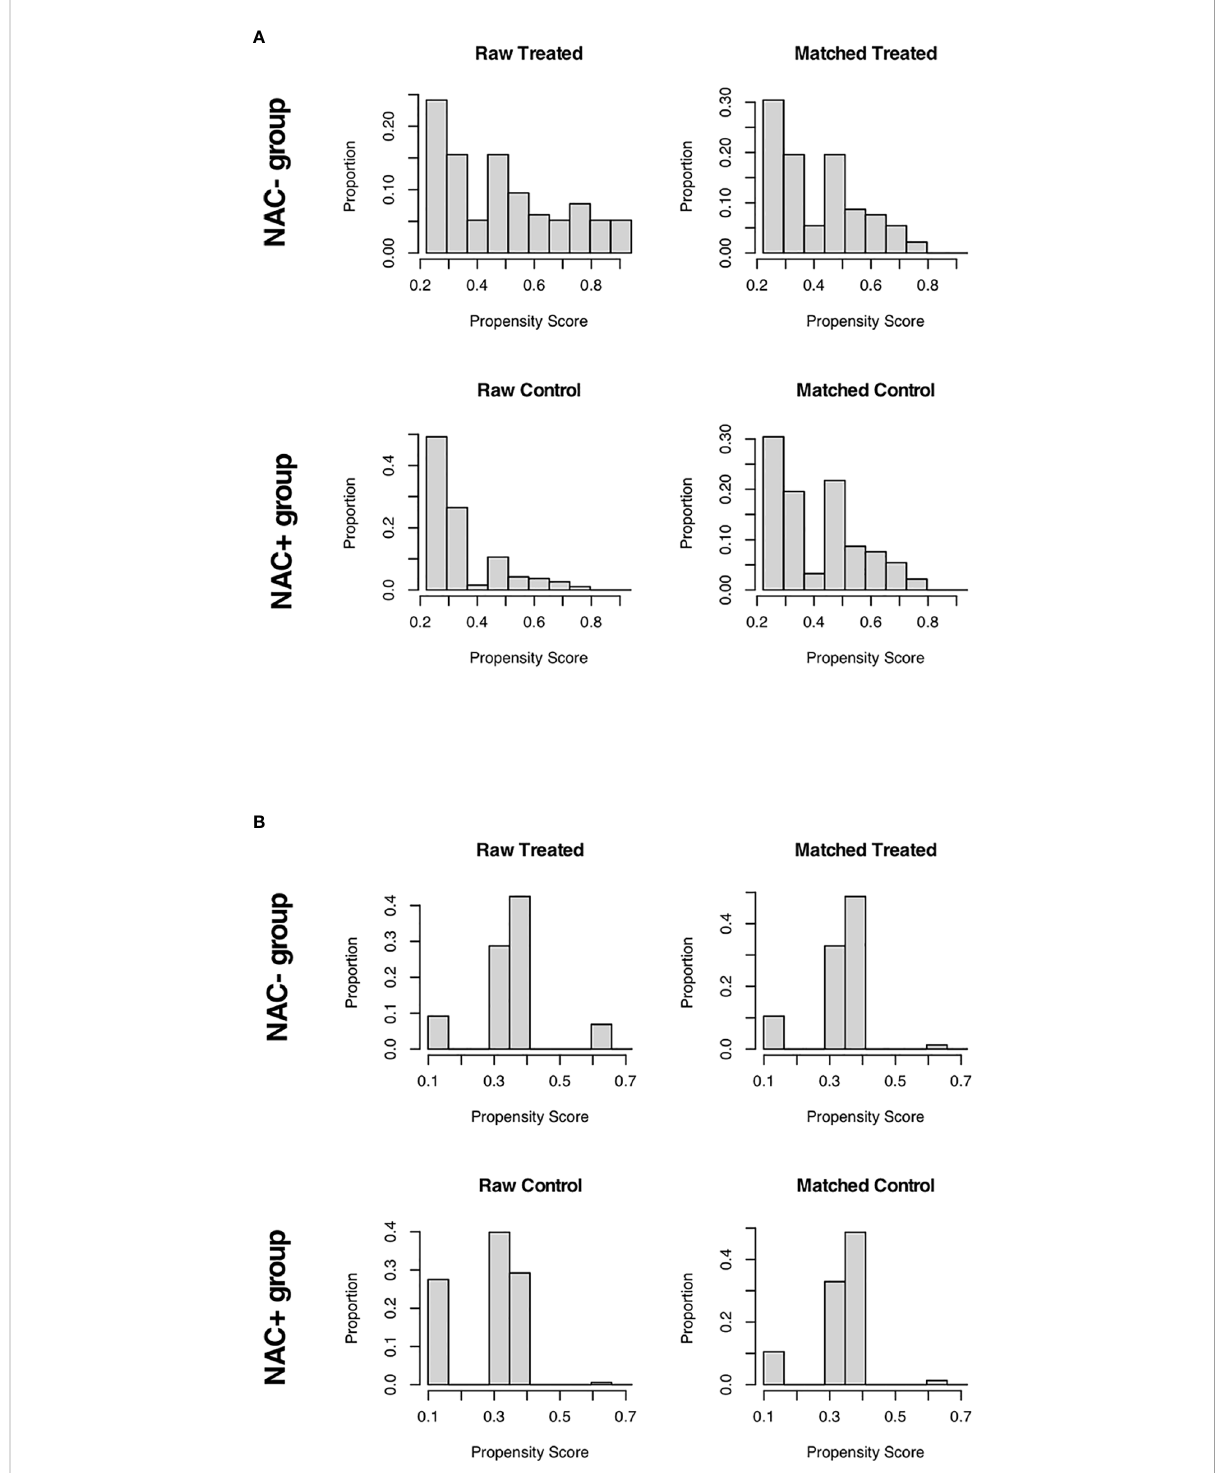
FIGURE 2 Distribution of propensity scores across the two groups: SEER cohort (A) ; NCC cohort (B)